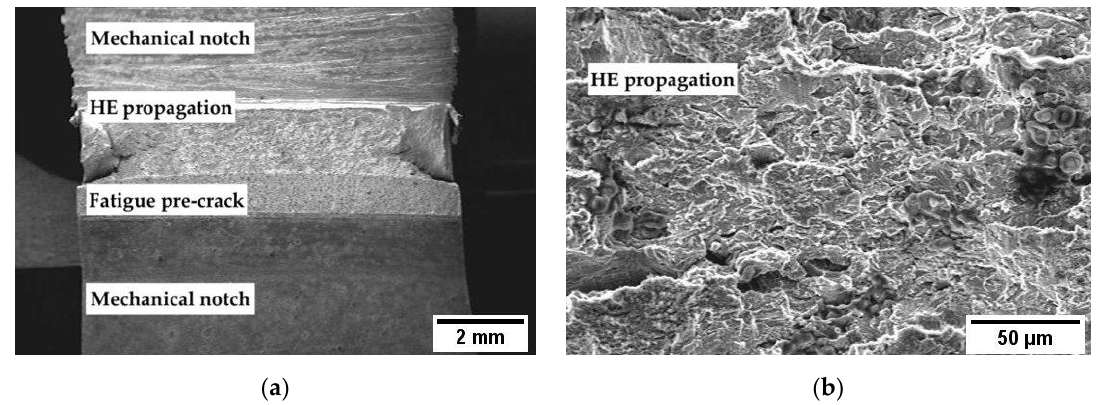
Figure 8. Fracture surface in J -integral test for X100 steel polarized at − 1 V vs. SCE: ( a ) macro and ( b ) close-up view of the crack propagation zone.